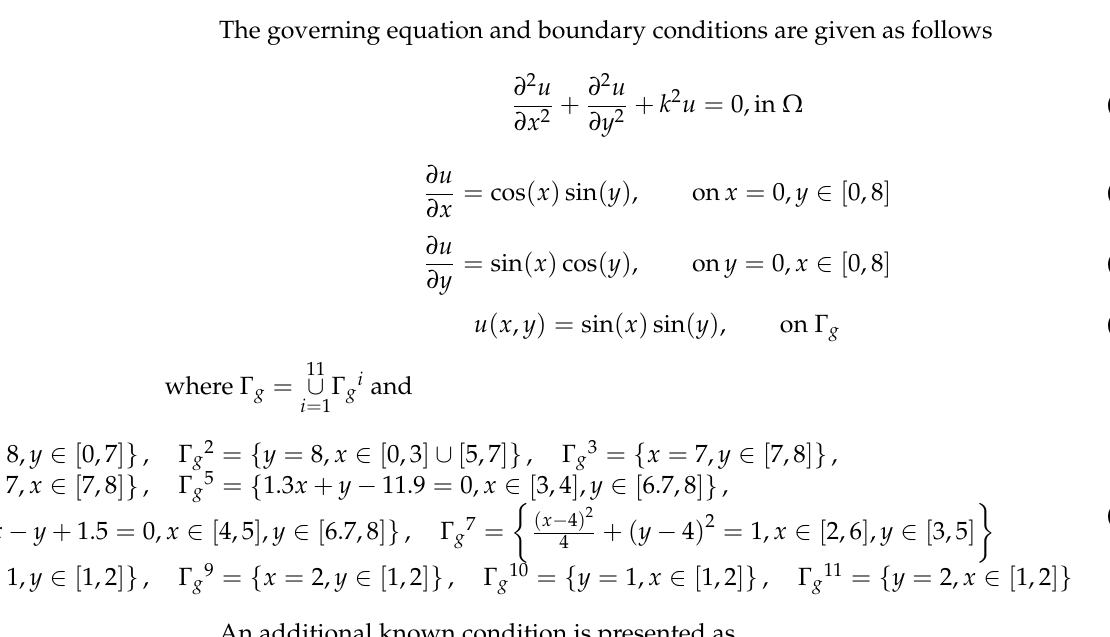
Figure 8. Configuration of 2D irregular geometry [33].